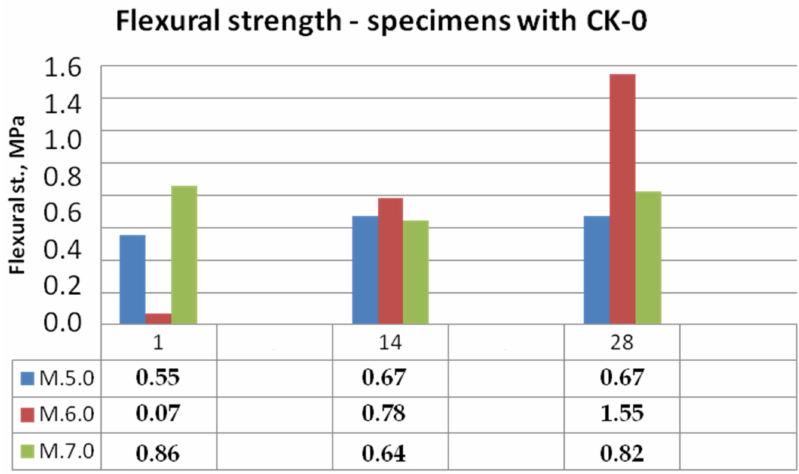
Figure 14. Bending strength of mortars with kaolin clay CK-0.